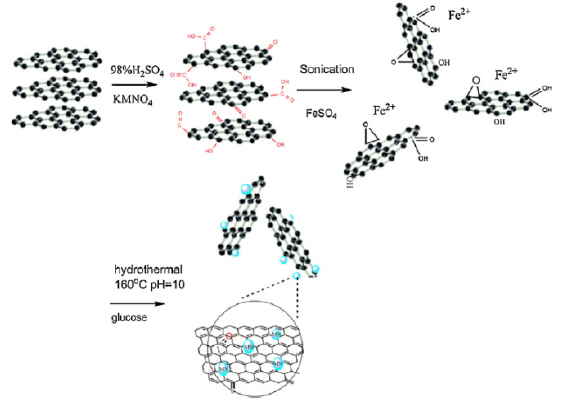
Figure 4. Synthesis of magnetic GO nanocomposite via precipitation method. (Reproduced or adapted from ref. [28], with permission from Elsevier, 2020).